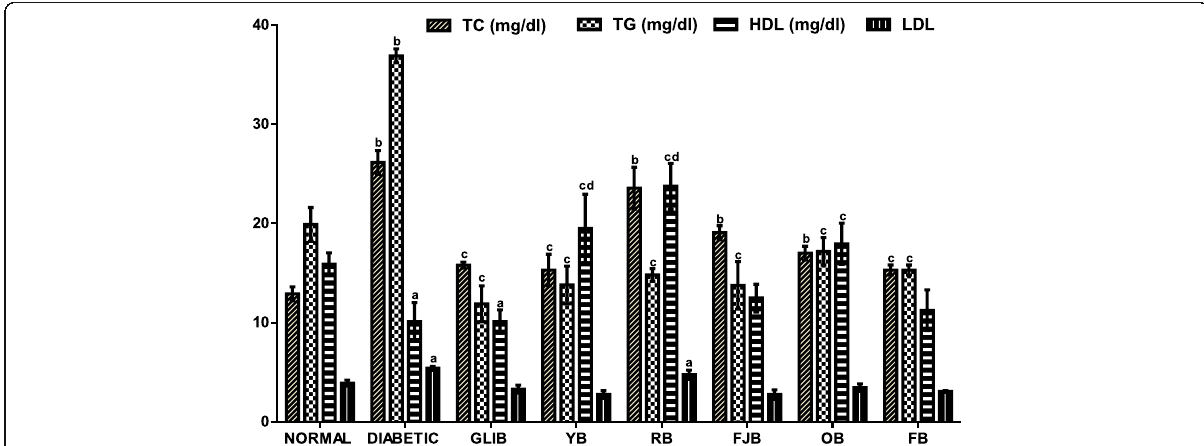
Fig. 3 effects of polyherbals on lipid parameters in normal and diabetic rats. Results represented as Mean ± S.E.M. n = 6. a p < 0.05 or b < 0.001 different from control normal CMC group. c p < 0.05 or d < 0.001 different from control Untreated Diabetic group. CMC: Carboxylmethyl